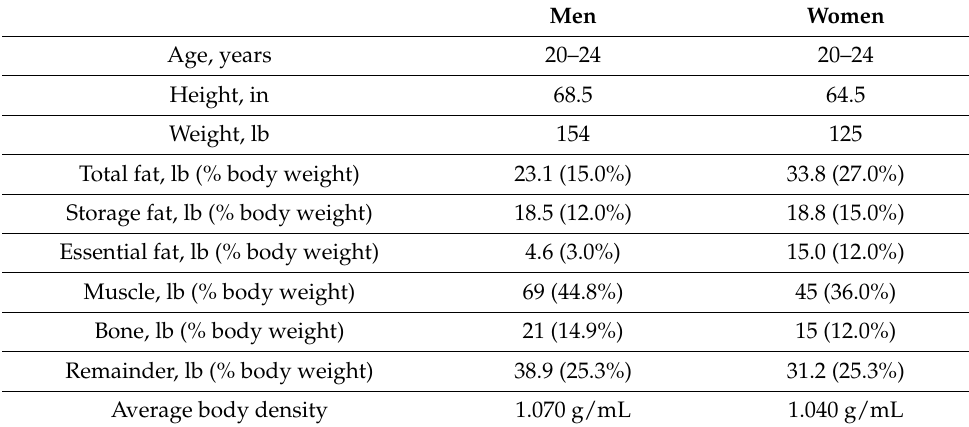
Table 1. Body compositions of Reference Men and Women